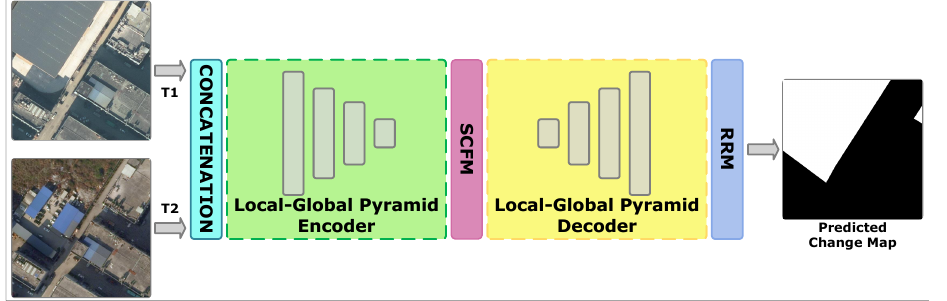
Figure 3. A brief illustration for proposed SCFNet. The SCFM and RRM indicate the self-attention convolution fusion module (SCFM) and residual refinement module (RRM), respectively.